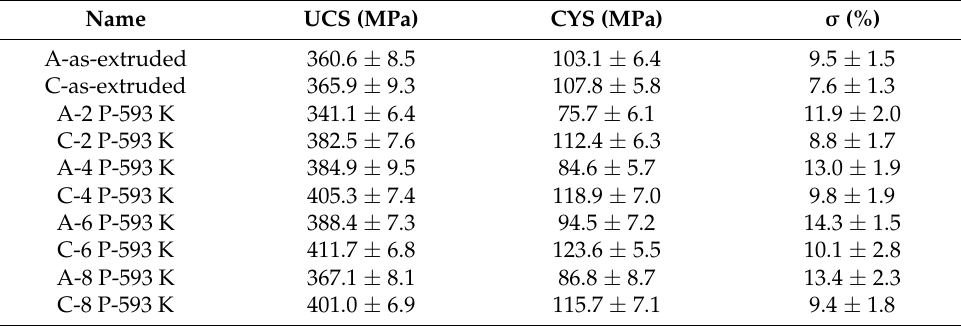
Figure 8. Compressive stress–strain curves of ( a ) Mg-3Zn-0.2Ca alloy and ( b ) 1 β -TCP/Mg-3Zn-0.2Ca 8. composites with different ECAP process parameters. Table 2. Summary of mechanical properties of the experimental Table 2. Summary of mechanical properties of the experimental specimens.